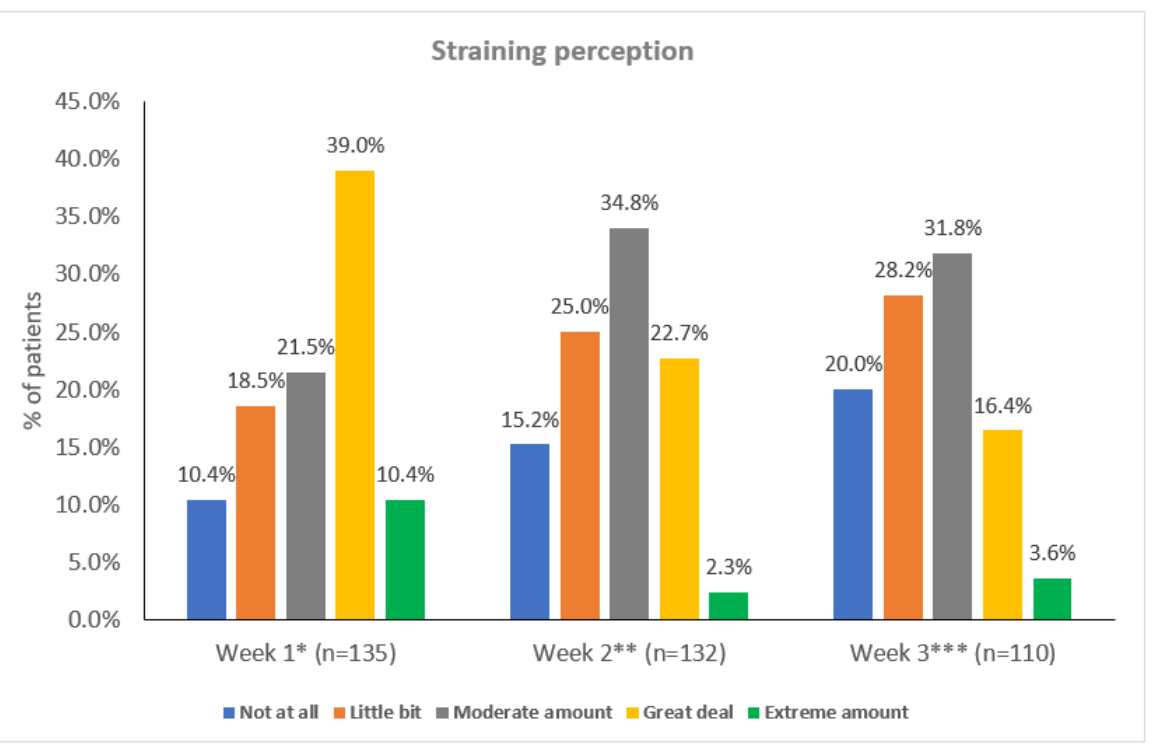
Figure 3. Straining perception during the study. * 8 missing data. ** 11 missing data. *** 9 missing data. Note: 24 patients did not complete Visit 3. data. Note: 24 patients did not complete Visit